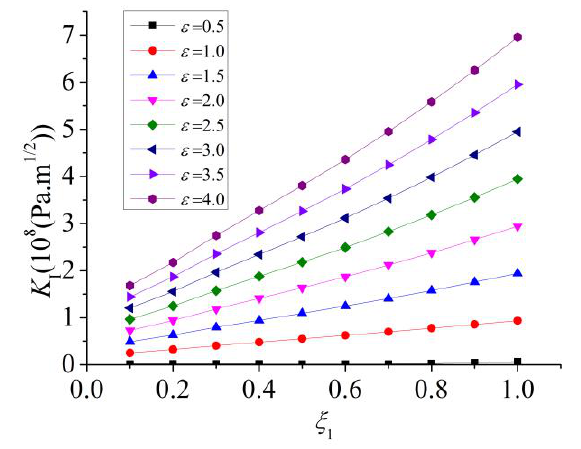
K  − curves for different eccentricities. Figure 17. K − ξ I 1 curves for different I 1